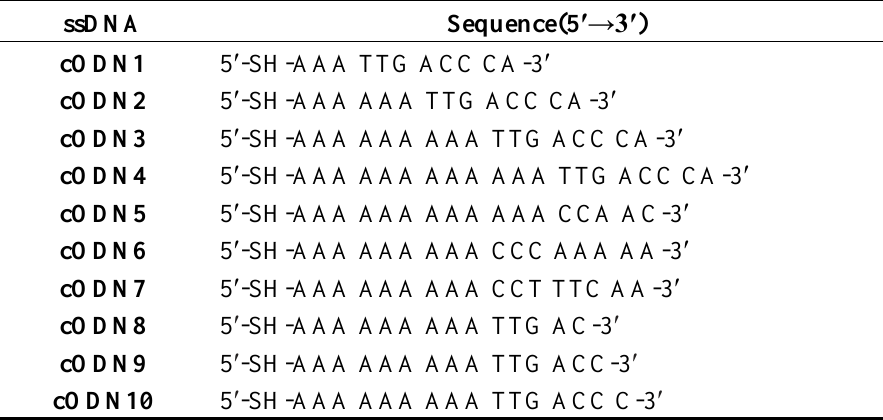
Table 1. The ssDNA sequence used in the